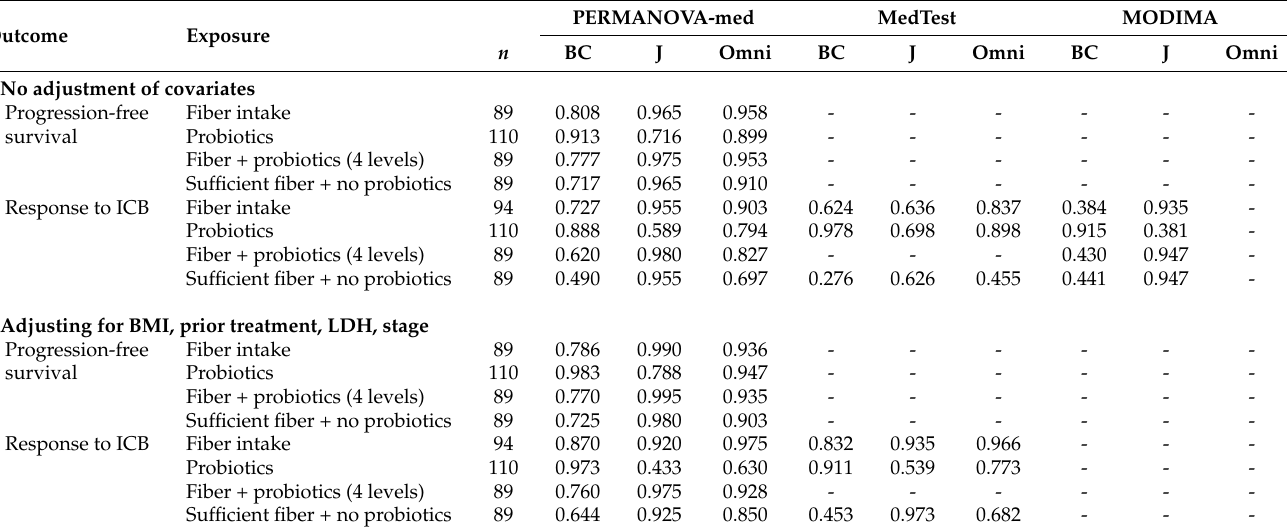
Table 3. p -values from 16 mediation analyses of the data on melanoma immunotherapy response.